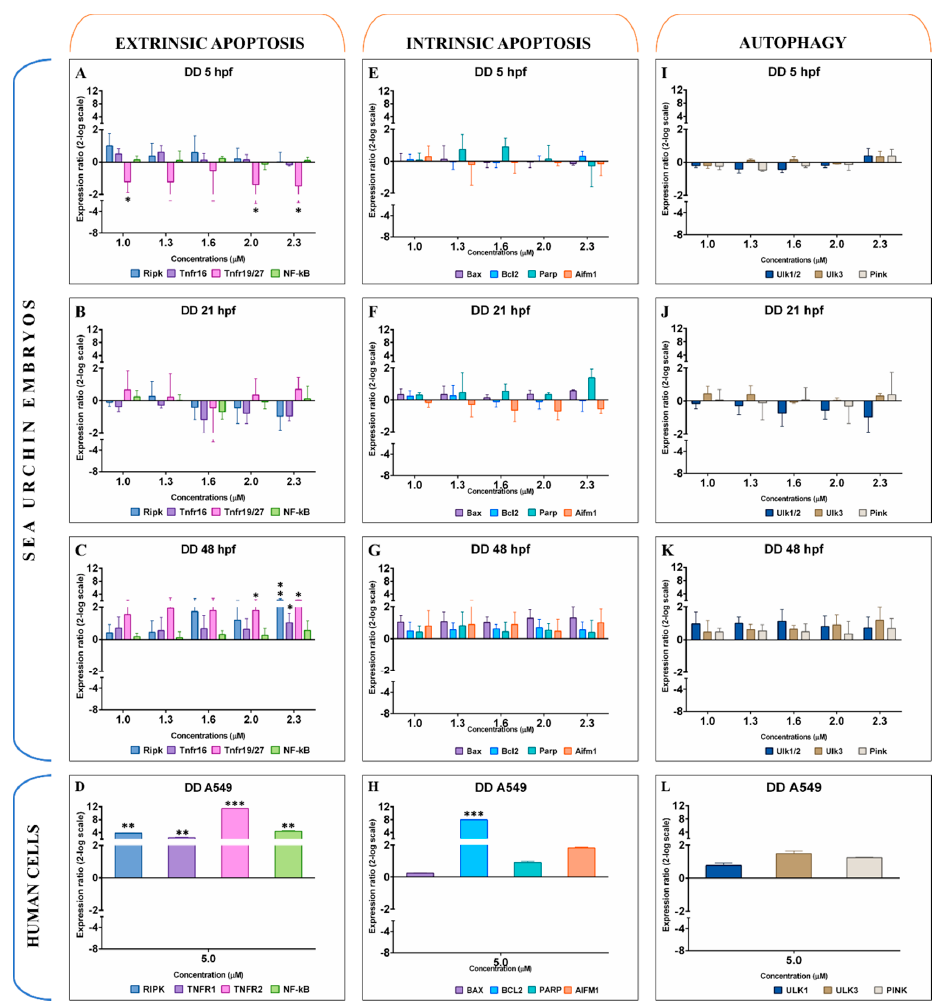
Figure 1. Gene expression levels of 11 genes belonging to extrinsic apoptosis ( A – D ), intrinsic apoptosis ( E – H ), and autophagy ( I – L ) in the sea urchin Paracentrotus lividus treated with 1.0, 1.3, 1.6, 2.0, and 2.3 μ M of decadienal for 5, 21, and 48 hpf and in A549 human cells treated with 5 μ M for 2 h. Samples obtained from three independent biological replicates were analysed by qPCR in technical triplicates. Data are reported as fold difference (mean ± SD), compared to controls without decadienal. Error bars represent the variation in biological replicates. Expression values were statistically analysed by Mann–Whitney U test, and values were considered significant if the p -value was <0.05 (* for p -value <0.05; ** for p -value <0.01; *** for p -value <0.001). Sea urchin embryos exposed to heptadienal did not show variation in gene expression at 5 hpf for the majority of genes studied (Figure 2A,E,I). Only Parp (Poly ADP-ribose polymerase) was downregulated at 2.0 μ M and upregulated at 2.5 μ M ( − 2.3 and 2.0 log2FC; Figure 2E). All genes were found downregulated at 21 hpf. Extrinsic apoptotic genes Ripk , Tnfr16 , Tnfr19/27 , and NF- κ B were downregulated by 2.5 μ M of heptadienal ( − 3.8, − 4.3, − 3.2, and − 3.8 log2FC, respectively); Ripk remained downregulated also at 5.5 and 6 μ M (Figure 2B). Parp and Aifm1 (Apoptosis-inducing factor, mitochondrion-associated, 1) were downregulated at 2.5 μ M ( − 4.0 and − 3.4 log2FC), with Parp remaining significantly downregulated at the two highest concentrations also ( − 2.9 and − 2.4 log2FC). Autophagic genes (Unc-51-like kinases 1/2 and 3 and PTEN induced putative kinase) were found